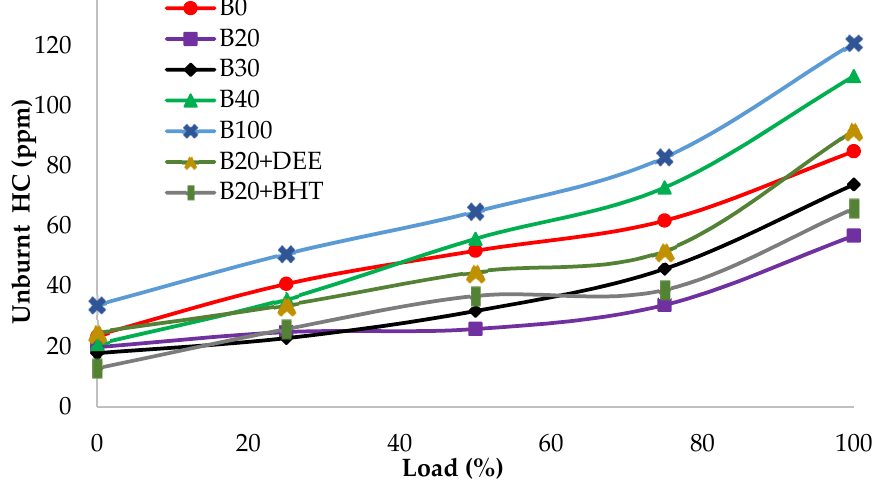
Figure 12. HC emissions of all fuel blends at different engine loads.